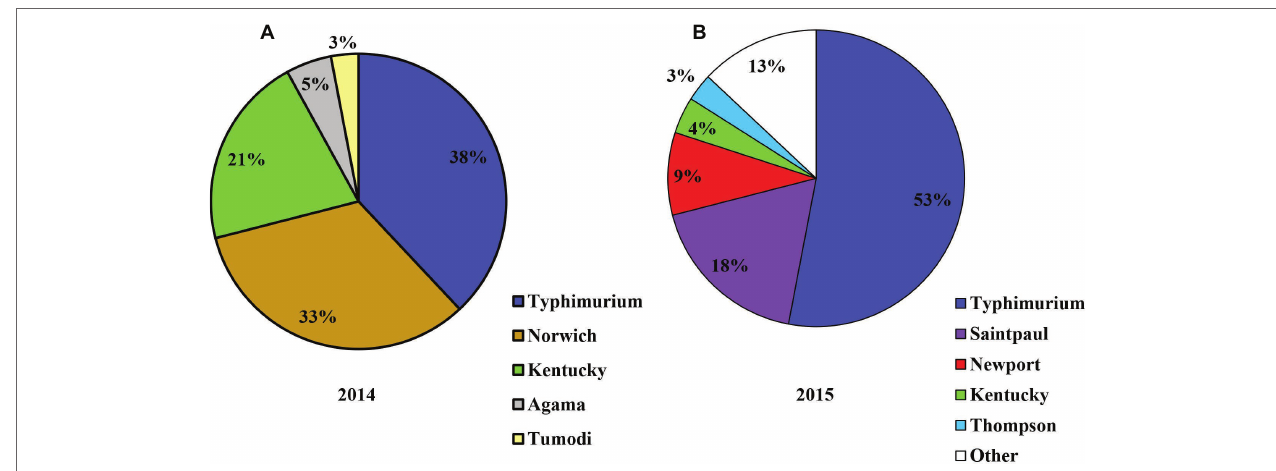
FIGURE 7 | Diversity of S. enterica serovars isolated from field soils of conventional farms applied with poultry litter on the ESV in 2014 [ (A) , n = 40] and in 2015 [ (B) , n =